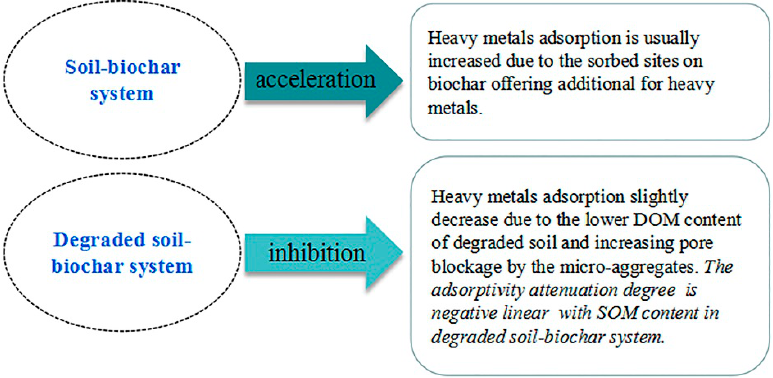
Figure 11. The adsorption inhibition and acceleration effect difference between soil–biochar system.